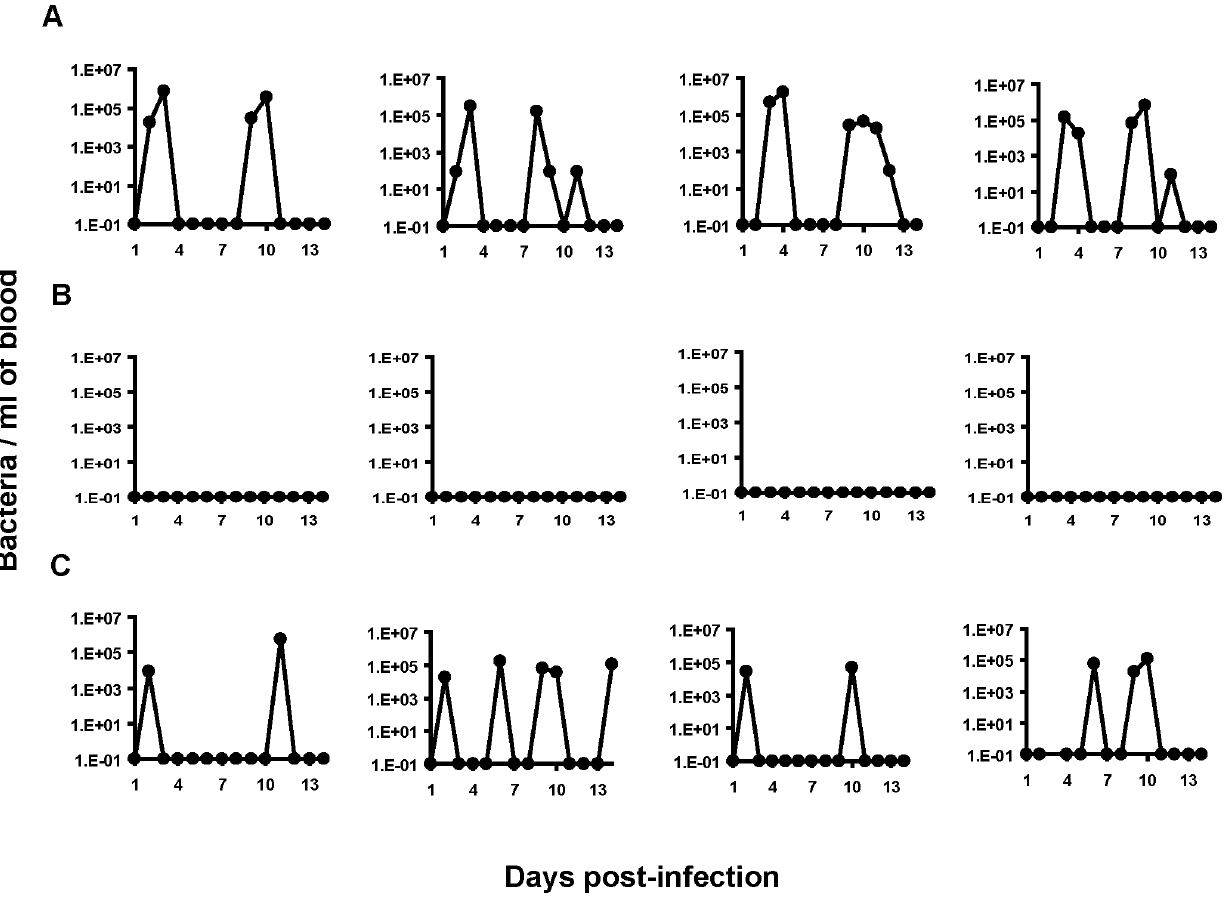
Figure 8. FliH is required for B.hermsii infectivity in mice. Kinetics of spirochetemia with wild-type B. hermsii (A), B. hermsii fliH mutant (B), B. hermsii fliH mutant complemented with pBhSV2:: pflgB - fliH (C). Each strain was inoculated intraperitoneally into groups of 4 mice and spirochetemia was monitored daily for 14 days. Each graph represents the spirochetemia determined for one mouse. The wild-type and complemented B. hermsii produced primary spirochetemias and a relapse (A & C) while the FliH mutant spirochetes produced no detectable spirochetemia (B).